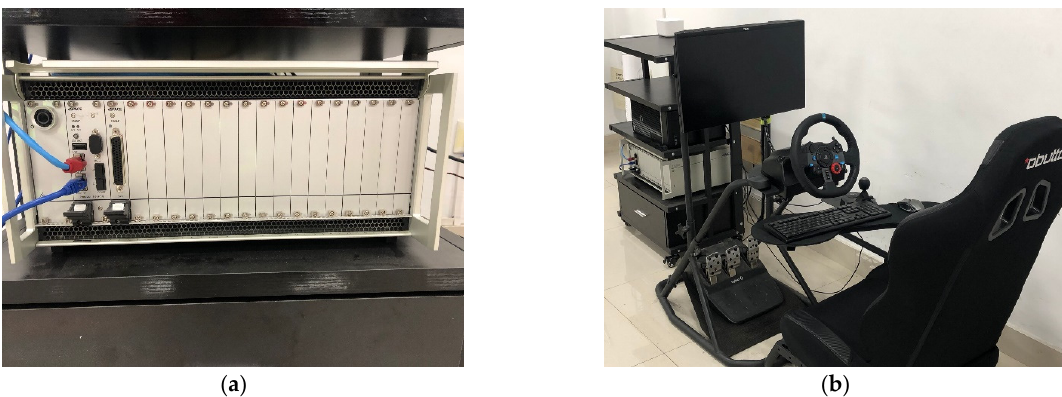
Figure 6. Simulation equipment. ( a ) dSPACE SCALEXIO; ( b ) driving simulator. Connect the dSPACE simulation device with the driving simulator and add the data measured by the real driver to the mathematical model, to conduct a simulation. We choose a road model. The model is controlled by the driver and simulated at different speeds. By using CarSim to output the parameter required by sideslip angle ob- servation and conducting real − time simulation analysis, we can obtain three different kinds of real trajectories, which are shown in Figure 7.